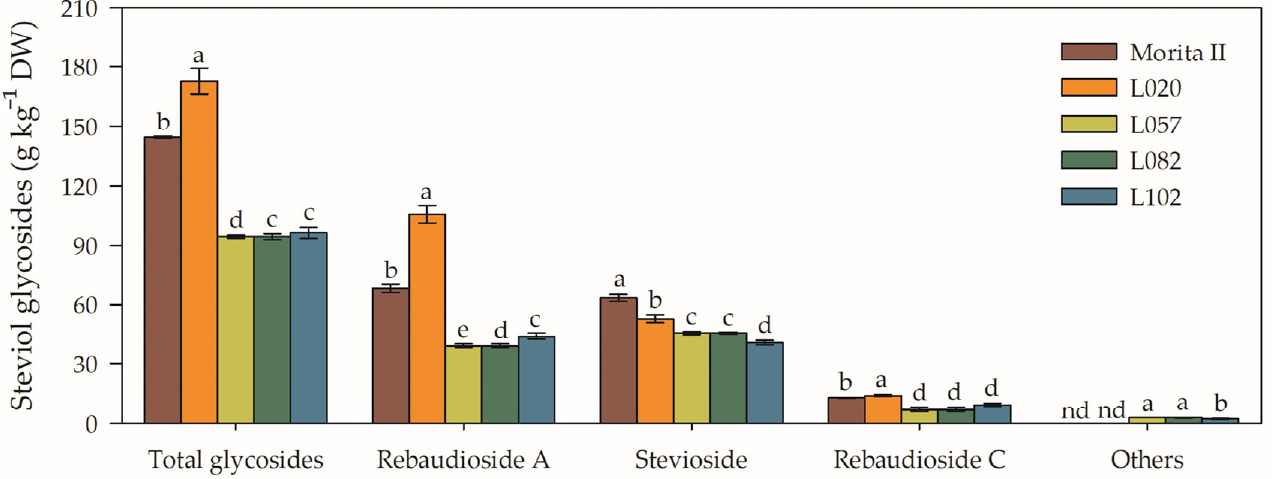
Figure 10. Total glycosides, rebaudioside A, stevioside, rebaudioside C, and other compounds evaluated in genotypes of Stevia rebaudiana (Morita II, L020, L057, L082, and L102) under land conditions in the complete absence of any plant stress. Means followed by different letters denote statistical significance ( p < 0.001). Means ± SD (n = 5). nd = not